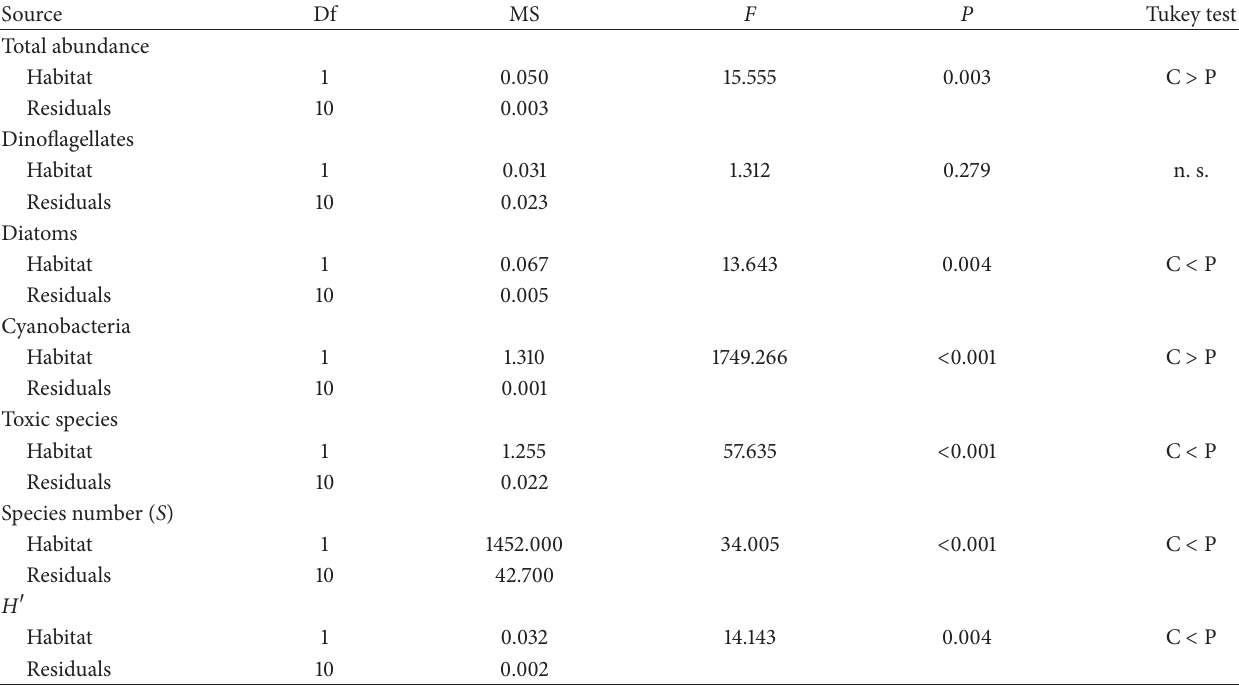
Table 3: Analysis of variance ANOVA of the abundances of major groups of microalgae and cyanobacteria in prospected stations.